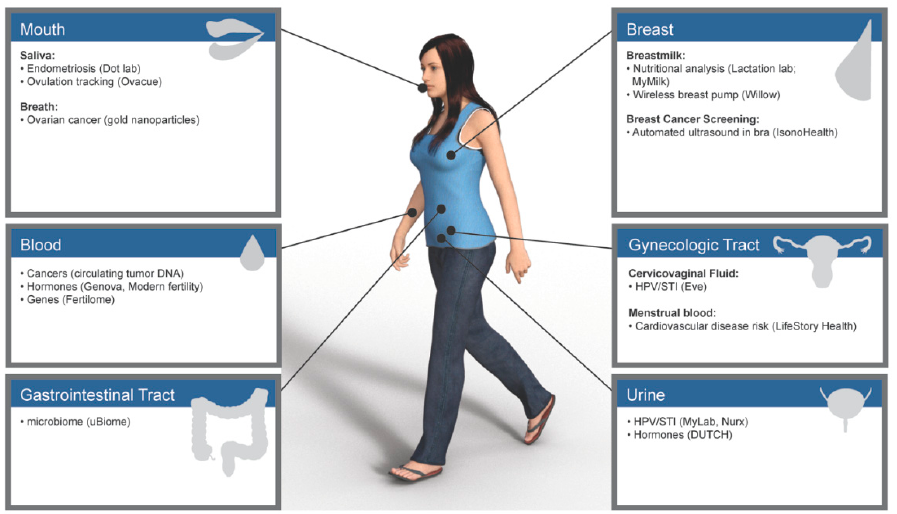
Figure 1. Emerging tests and technologies by anatomic site.